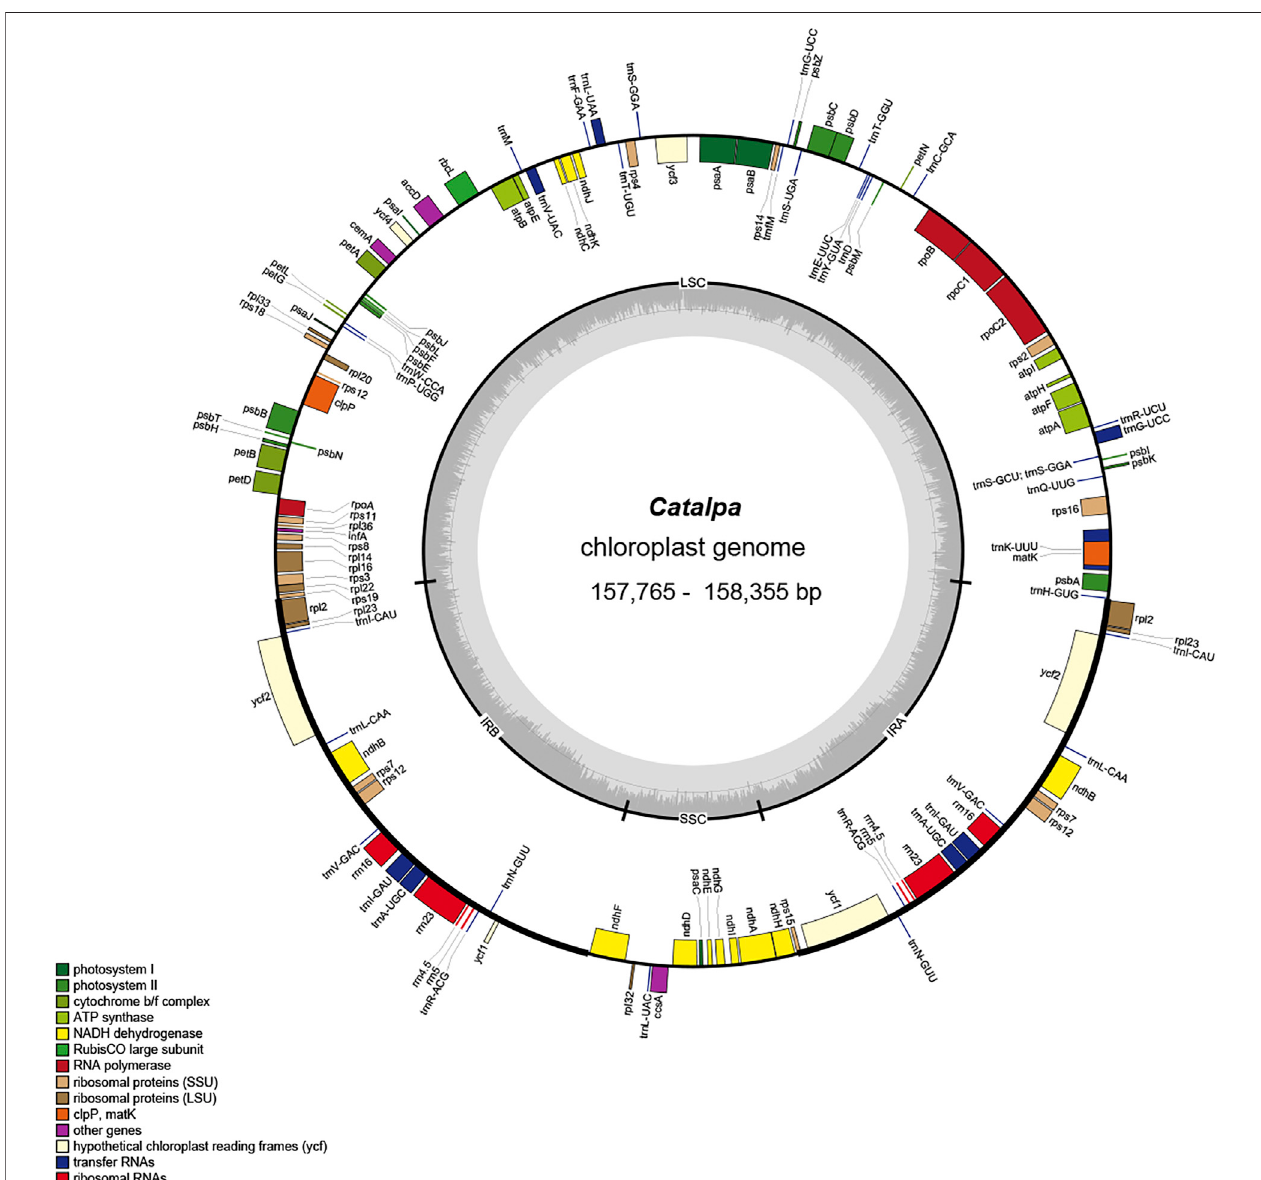
FIGURE 1 | Gene map of the Catalpa chloroplast genome. Genes shown outside the outer circle are transcribed clockwise, and those insides are transcribed counterclockwise. Genes are color coded according to different functional groups. The darker gray in the inner circle indicates the GC content, and the lighter gray indicatestheATcontent.Theinnercirclealsoshowsthatthechloroplastgenomecontainstwocopiesofinverted repeats(IRAandIRB),alargesingle-copy(LSC)region and a small single-copy (SSC) region. The map was constructed using OrganellarGenomeDRAW.